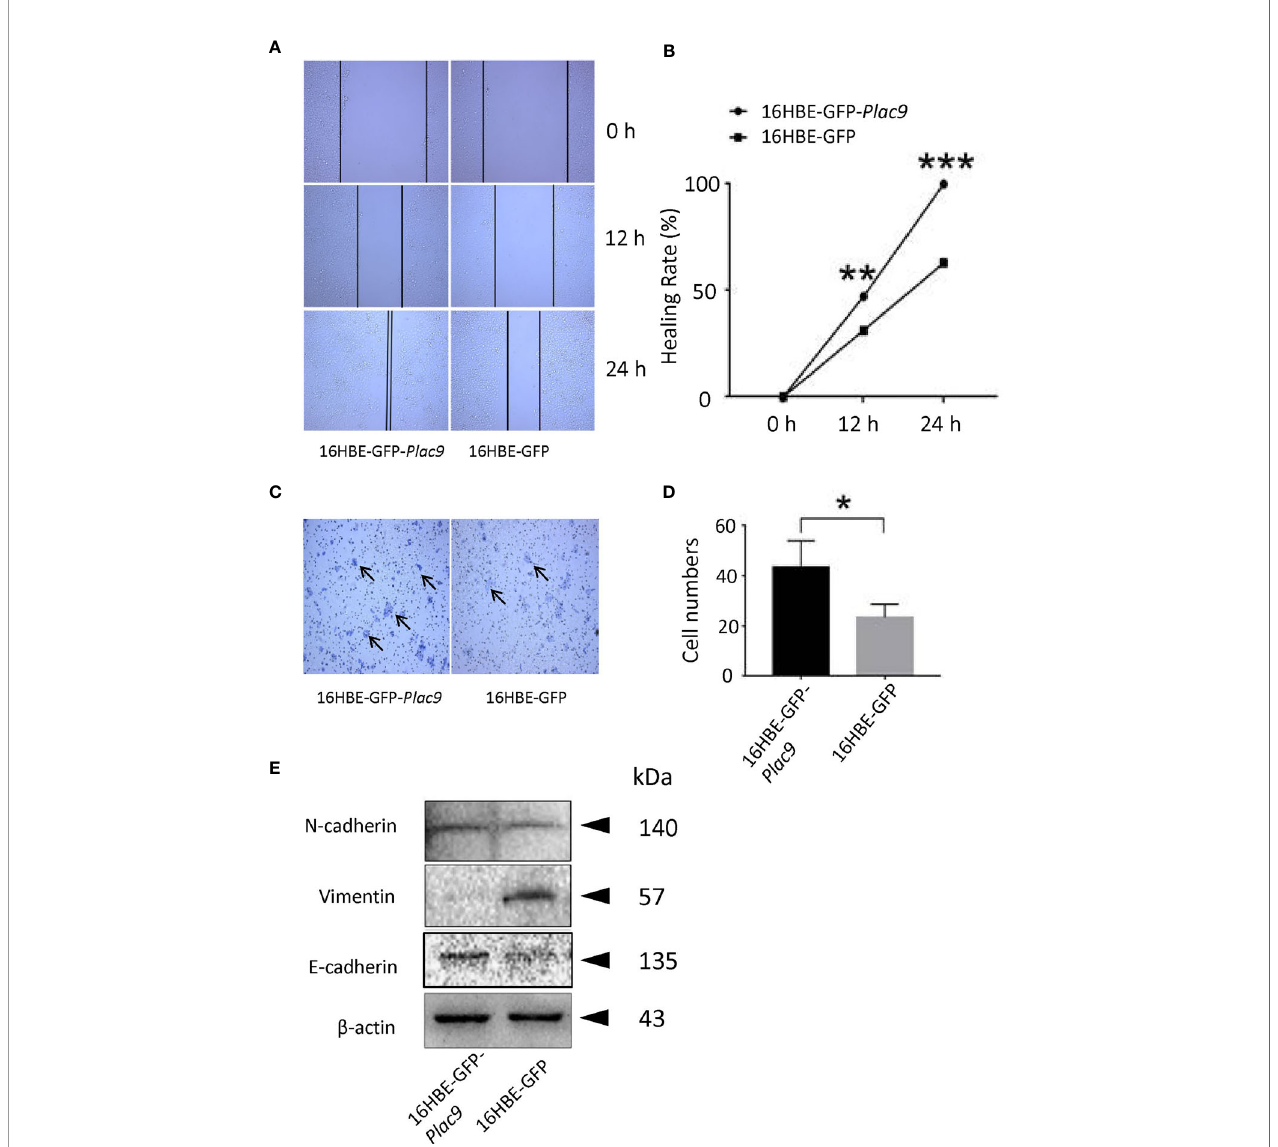
FIGURE 8 | Overexpression of PLAC9 enhances cell migration. (A, B) PLAC9 increases cell motility in a wound-healing assay. PLAC9 overexpressing stable cell line (16HBE-GFP- Plac9) and the control line 16HBE-GFP were cultured for 0, 12, or 24 h in the wound-healing assay (A) . The wound healing rate for 16HBE-GFP- Plac9 was 42.01 ± 5.05% and 85.93 ± 7.56% at 12 h and 24 h, respectively, while for 16HBE-GFP, it was 29.28 ± 1.76% and 56.64 ± 5.75% at 12 h and 24 h, respectively (B) . (*p < 0.05, **p < 0.01, ***p < 0.001). (C, D) PLAC9 increases cell invasion. PLAC9 overexpression stable cell line (16HBE-GFP- Plac9) and the stable control line (16HBE-GFP) were cultured for 48 h in the transwell cell invasion assay (C) and quanti fi ed (D) . (*p < 0.05, **p < 0.01, ***p < 0.001). (E) PLAC9 alters the expression of cell migration-related proteins Total proteins of PLAC9 overexpressing stable cell line (16HBE-GFP- Plac9) and the control line (16HBE-GFP) were isolated for western blot